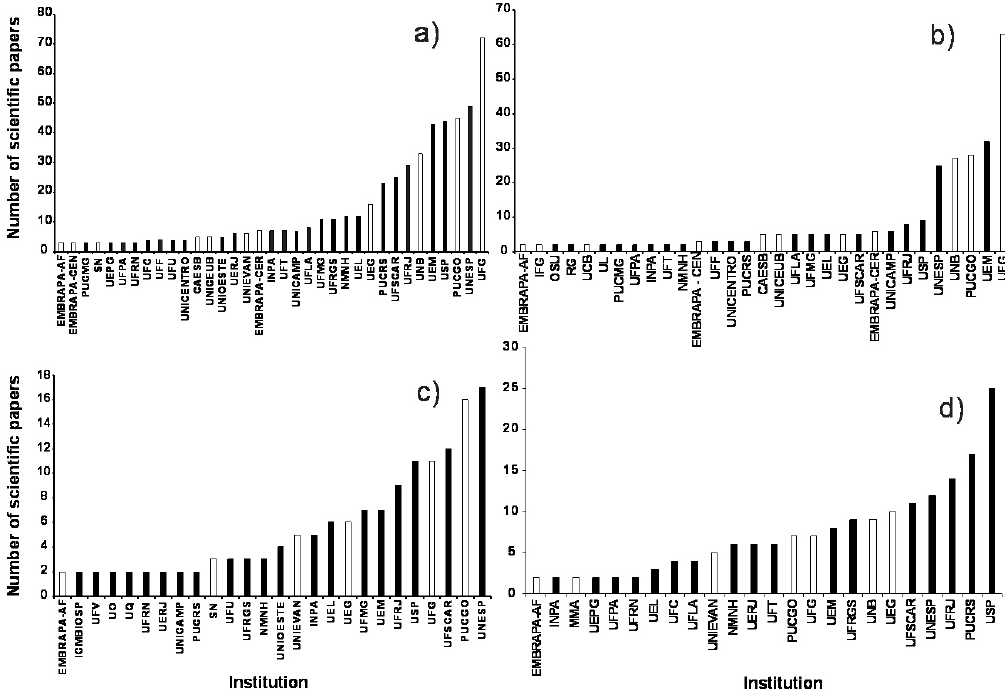
Figure 3. Number of scientific papers published per institution in all three basins combined (a), Paraná (b), Araguaia (c) and Tocantins River basin (d) in Goiás State. Institutions are identified according their location inside (white bars) or outside (dark bars) Goiás State. In (a) only institutions with three or more publications are